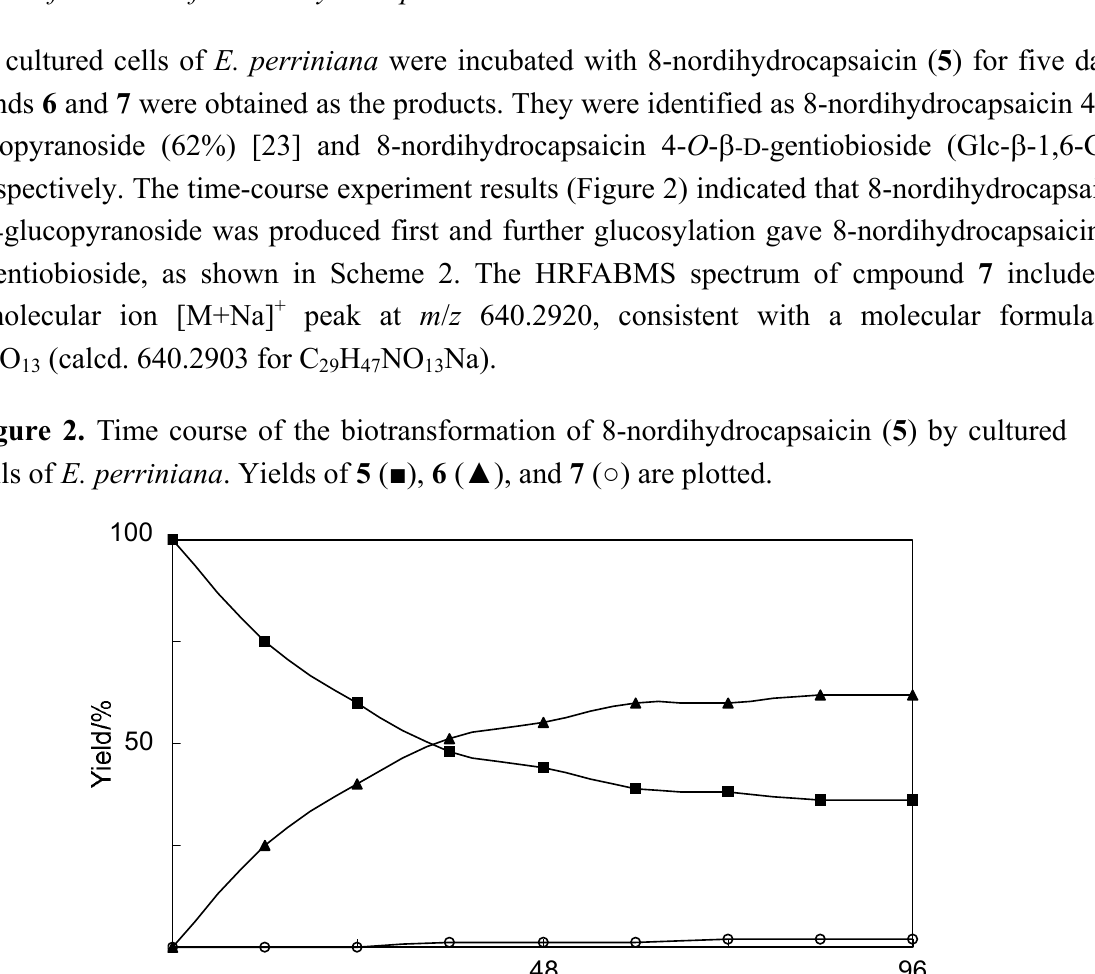
The 1 H NMR spectrum of compound 7 included proton signals at  4.35 (1H, d , J = 7.2 Hz) and 4.92 (1H, d , J = 7.6 Hz), indicating the presence of two  -anomers in the sugar moiety. The 1 H-